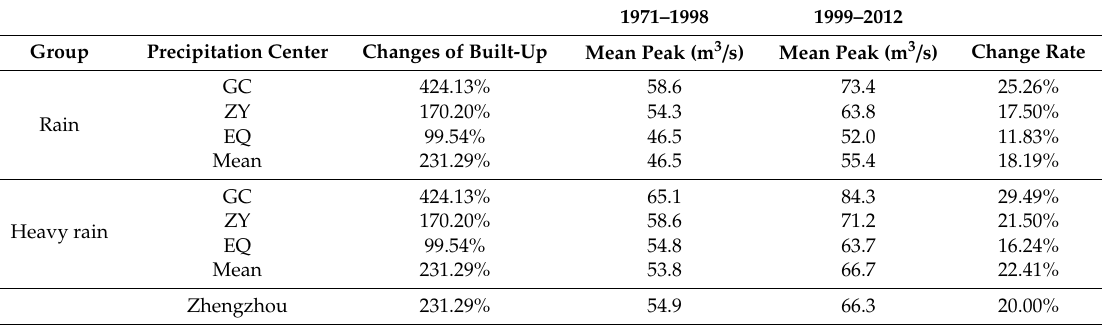
Table 6. Flood peak statistics.